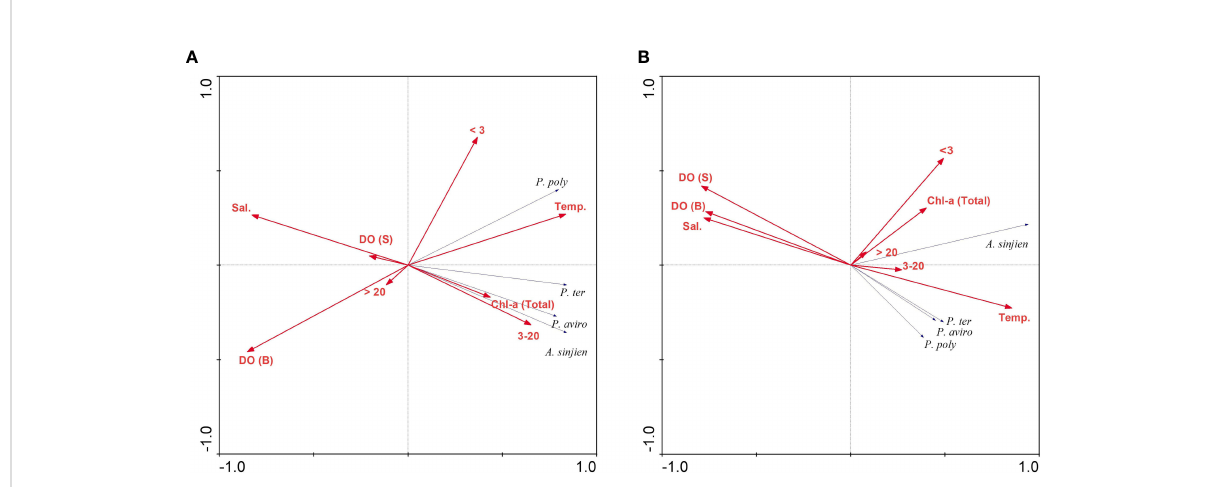
FIGURE 8 Results of the redundancy analysis (RDA) biplot of dominant species and environmental variables in the (A) inner bay and (B) middle bay. Dominant species are abbreviated as: P . poly , Pleopis polyphemoides ; P . ter , Pseudoevadne tergestina ; P . aviro , Penilia avirostris ; A. sinjien , Acartia sinjiensis . Environmental variables are abbreviated as: Temp., Temperature; Sal., Salinity; DO (S), Dissolved oxygen (surface) concentration; DO (B) , Dissolved oxygen (bottom) concentration; Chl- a (Total), total Chl- a concentration; > 20, > 20 µm categories of Chl- a